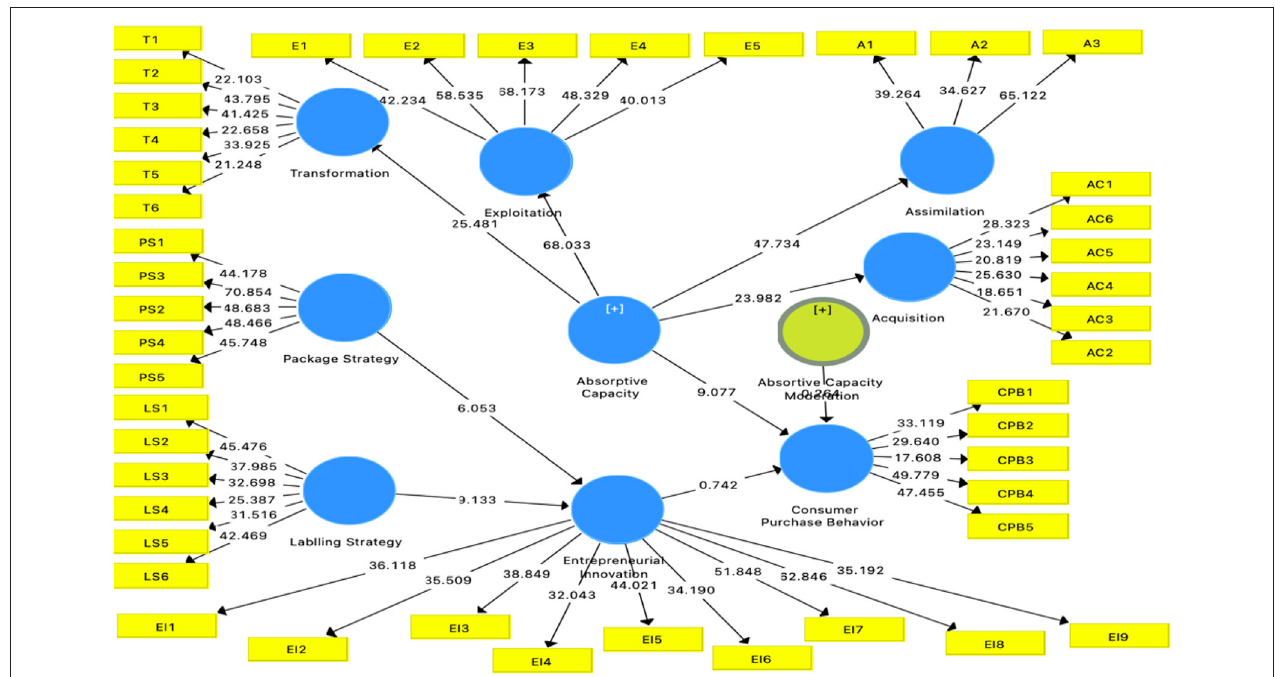
FIGURE 4 | Moderation